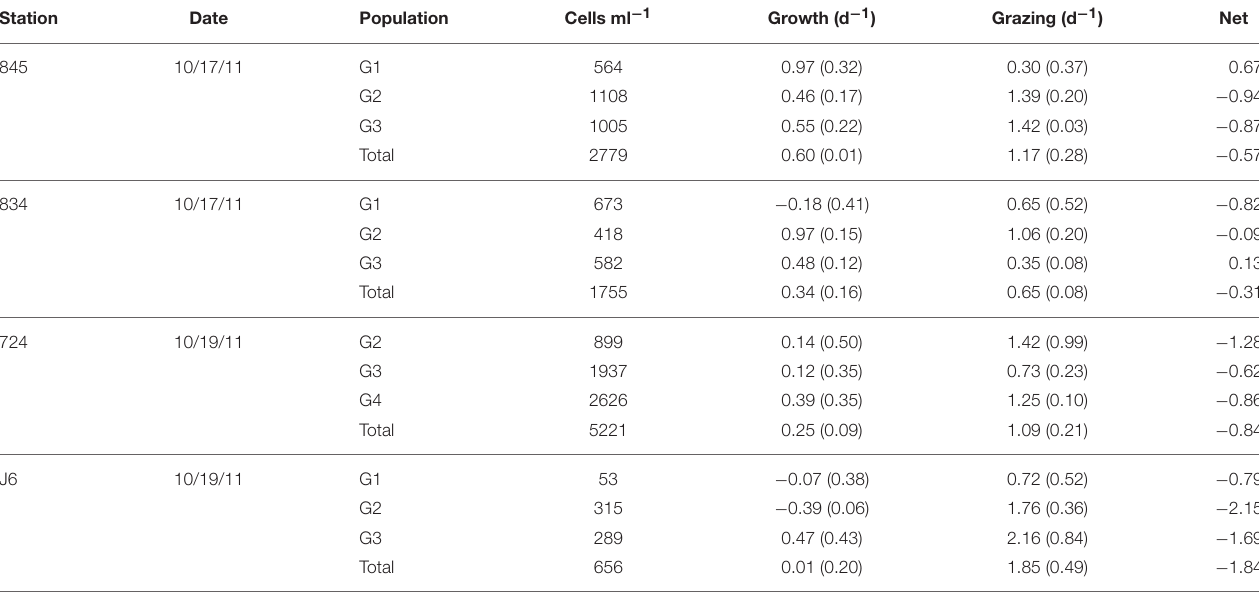
TABLE 2 | Population-specific apparent growth and grazing rates for cryptophyte algae during dilution experiments in Chesapeake Bay.